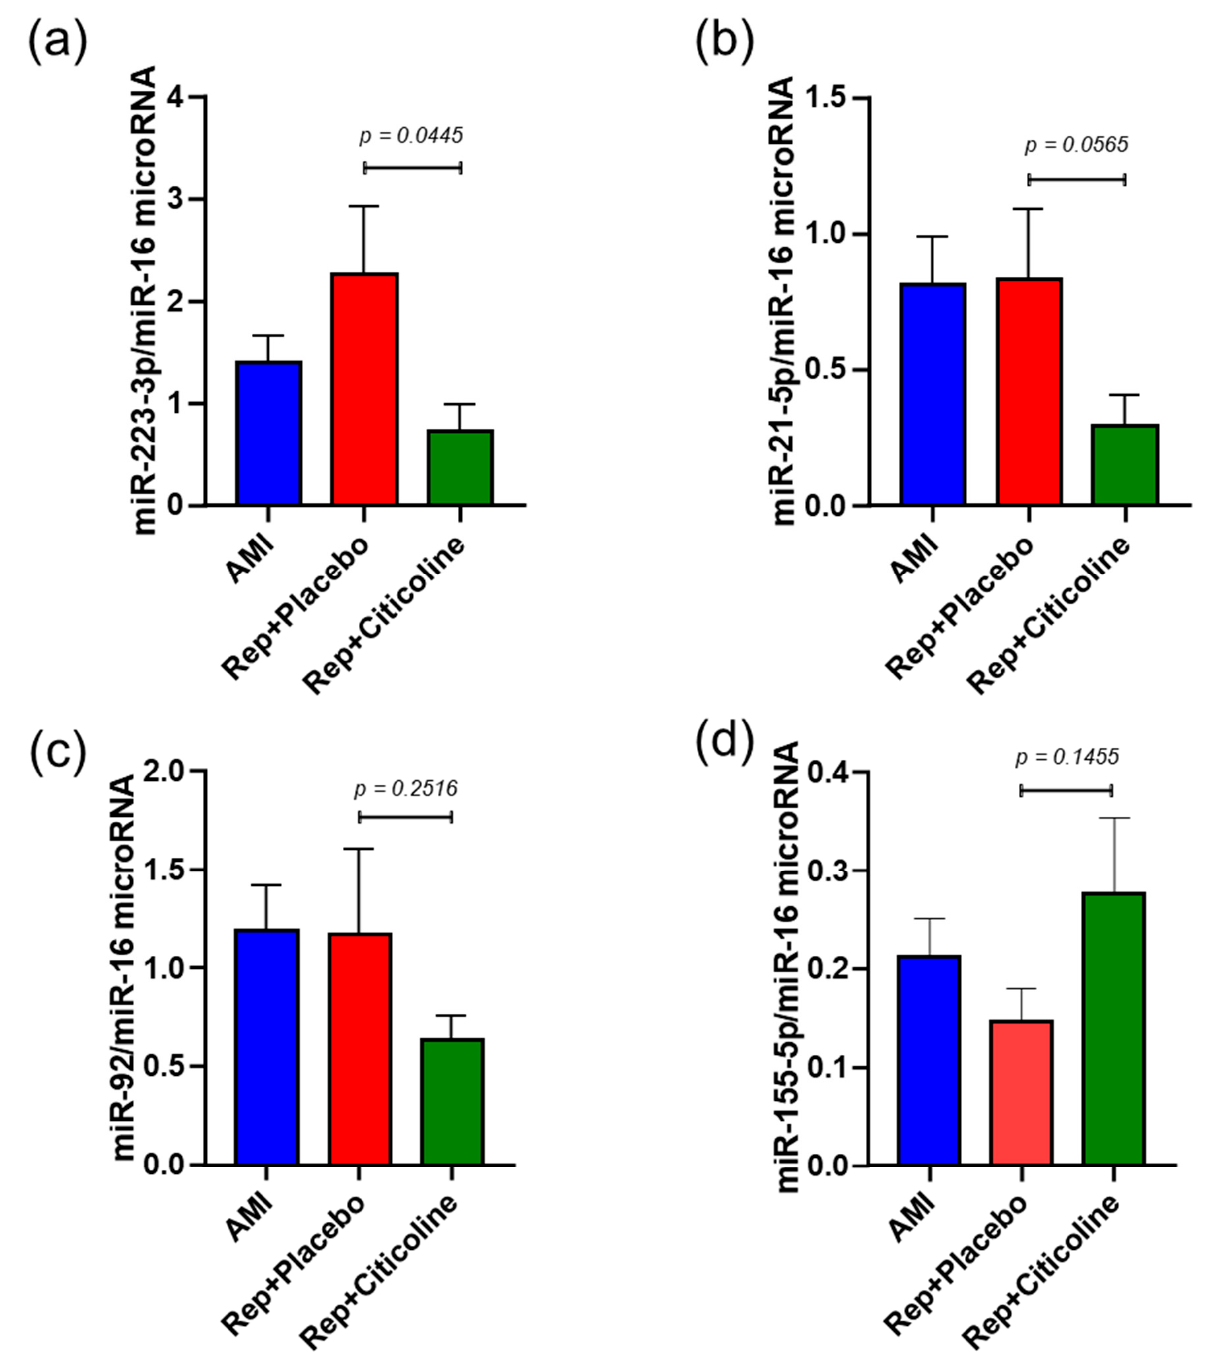
Figure 4. Differentially expressed miRNAs transcripts in exosomes obtained from plasma of AMI patients subjected to coronary angioplasty and treated with citicoline. Relative concentrations of ( a ) miR-223-3p, ( b ) miR-21-5p, ( c ) miR-92, ( d ) miR-155-5p were normalized with values of cel-miR-16 content and values were calculated using the 2 − ∆ Ct formula. Results are shown as mean ± SD of at least 10 exosome samples from different patients of each group and were analyzed with the Mann–Whitney test.